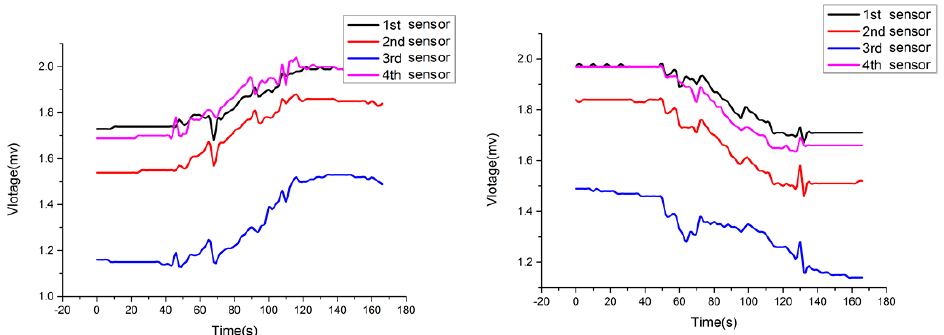
Figure 22. Tension curves of four wire ropes when a valve is closed.